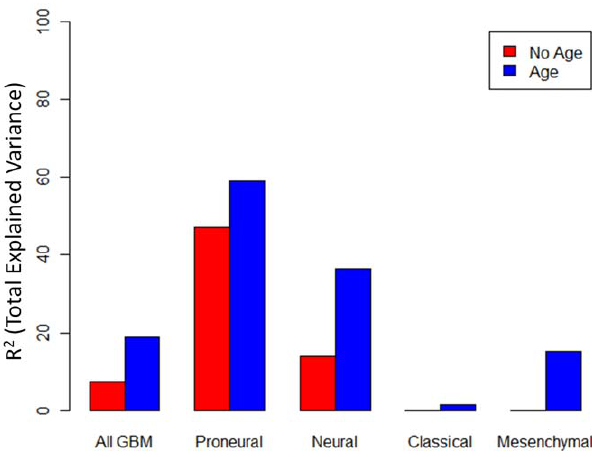
Figure 2. Bar plot of total explained variance (R 2 ) for survival models discovered using stepwise selection with genes only (‘‘No Age’’) or with genes and age (‘‘Age’’) for all GBM patients and by subtype.